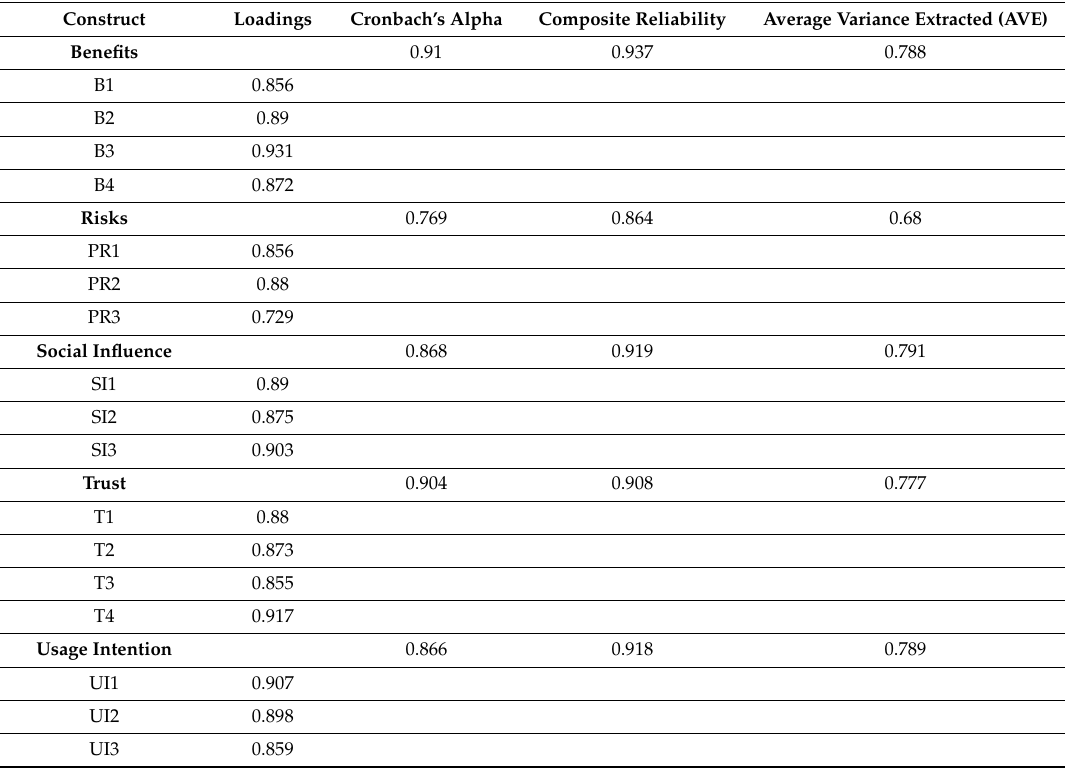
Table 2. Results of the measurement model analysis.